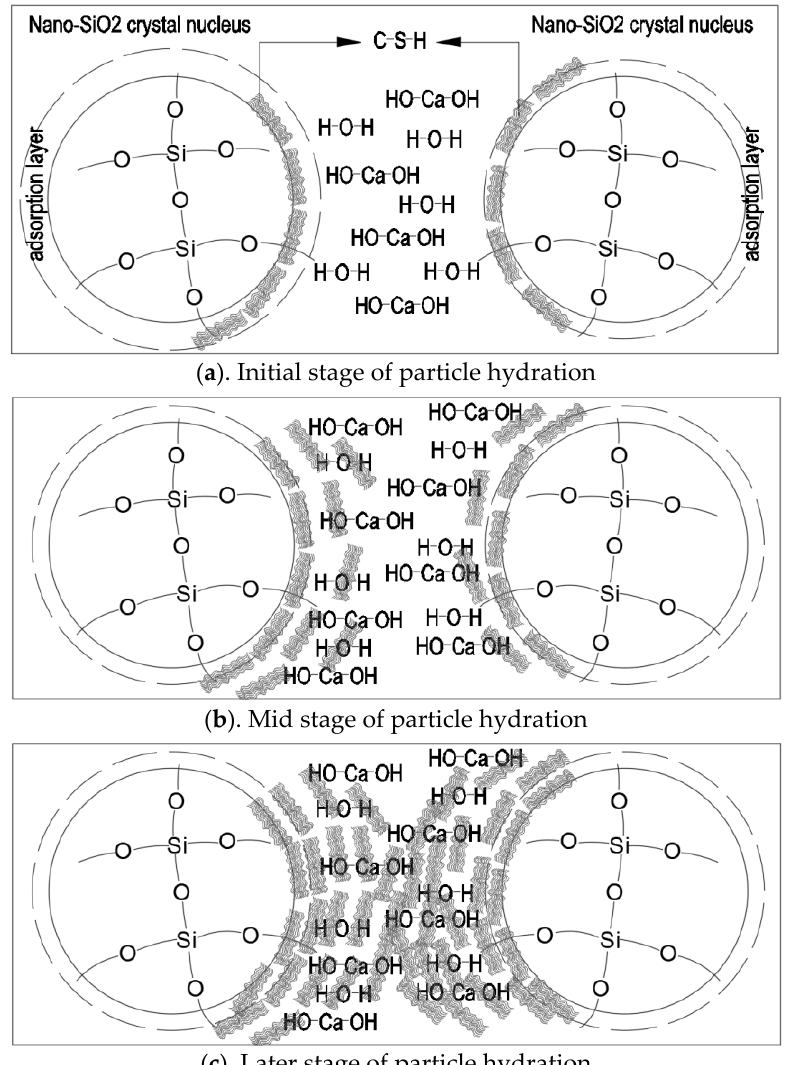
Figure 9. Microstructural model of precipitated nano-SiO 2 particles.